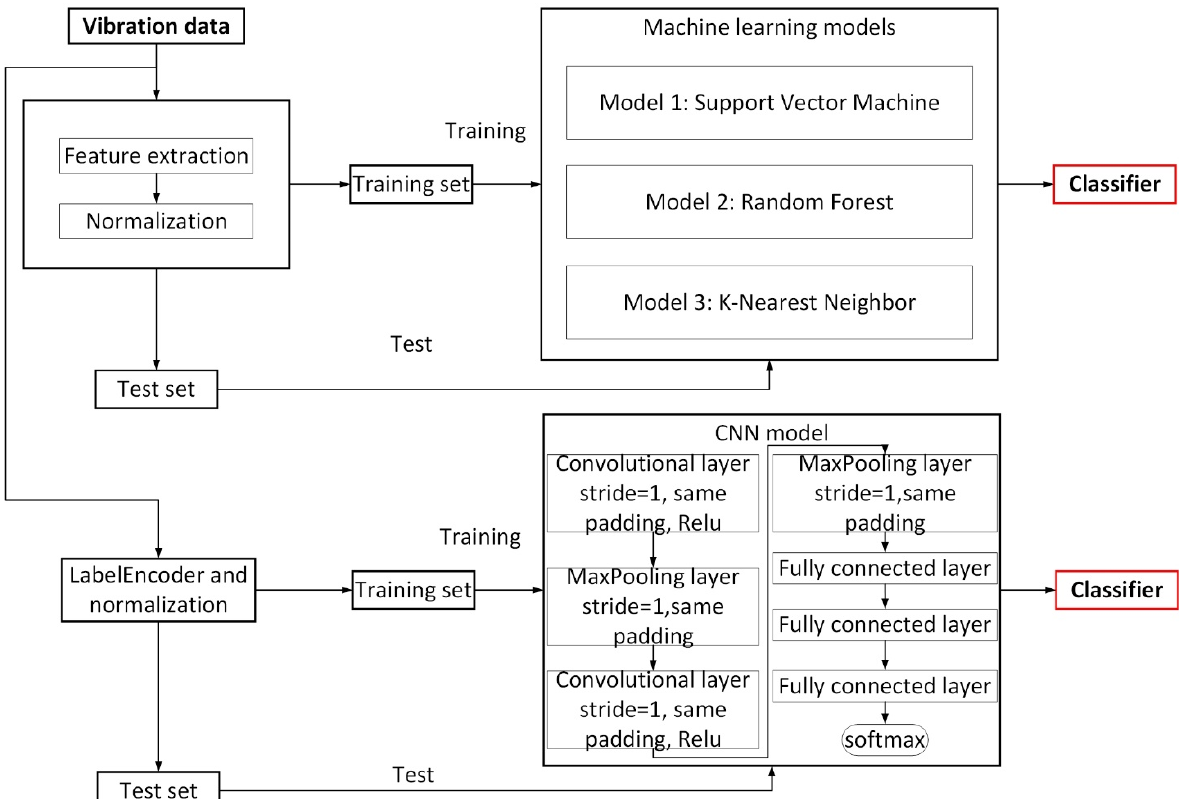
Figure 1. Flowchart of the proposed approach for texture recognition.